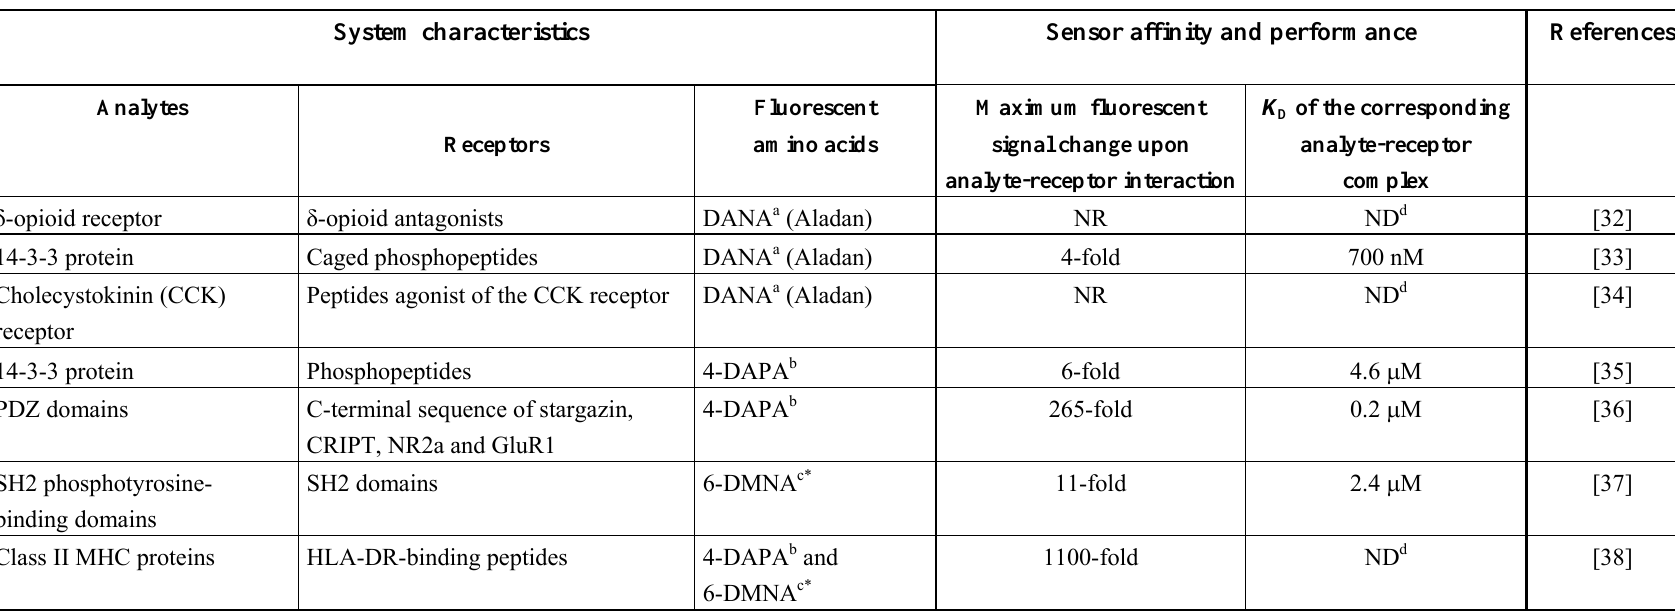
Table 2. Environmentally sensitive peptide biosensors constructed by incorporating a fluorescent amino acid in the peptide